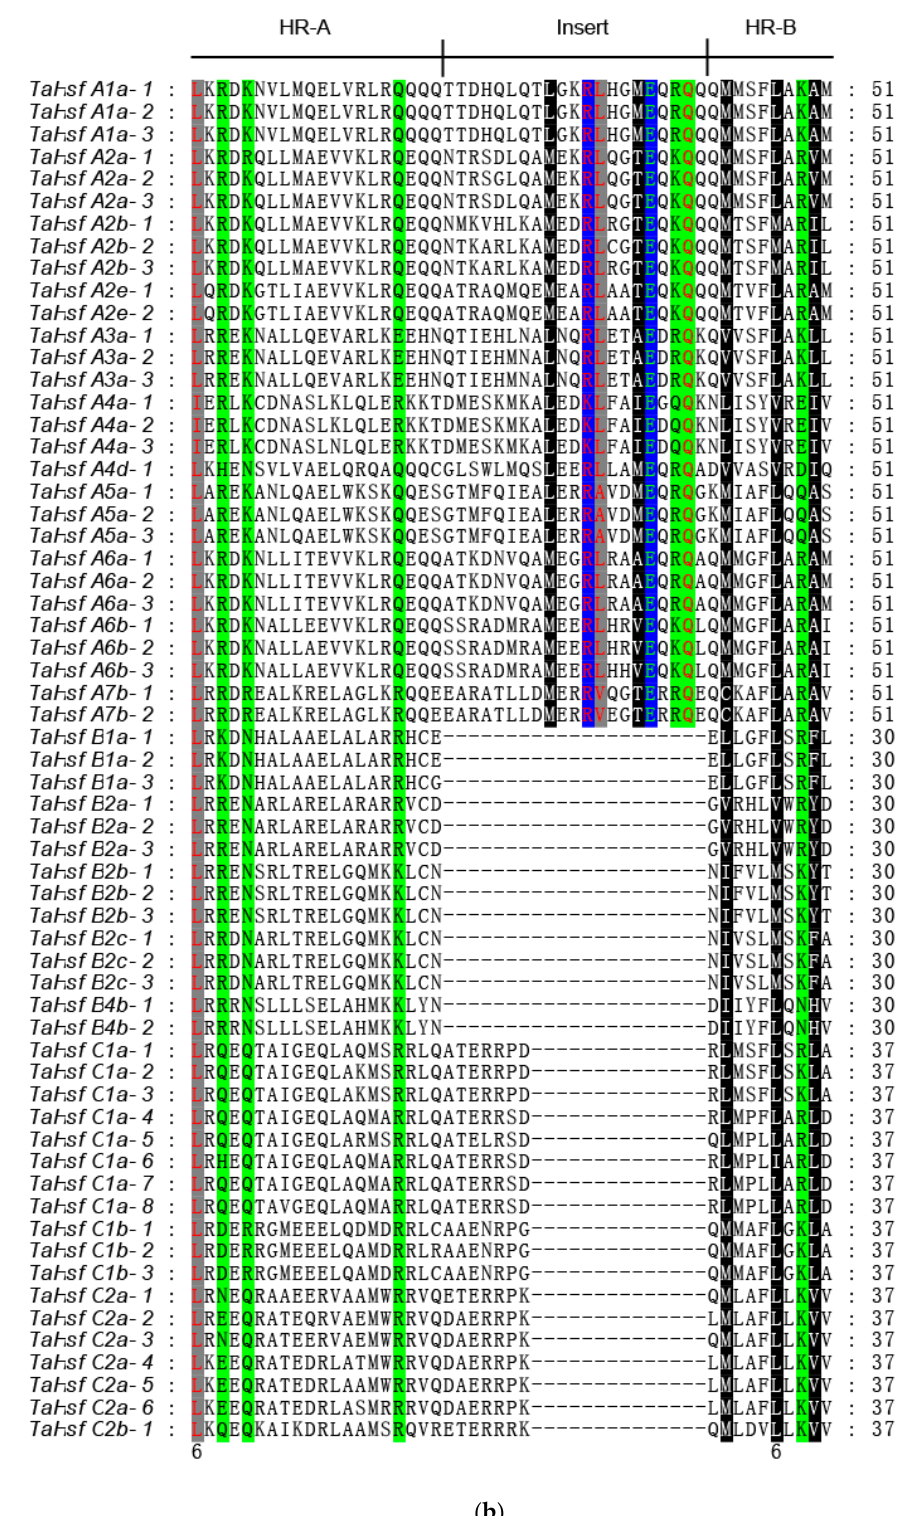
Figure 4. Analysis of the conserved DNA-binding domain (DBD) domains and oligomeric domain (OD) regions in the 61 TaHsfs . ( a ) Multiple sequence alignment of the DBD domains in 61 TaHsfs . ( b ) Multiple sequence alignment of the heptad repeat A / B (HR-A / B) regions in 61 TaHsfs . The scheme at the top shows the locations and boundaries of the HR-A core, insert, and HR-B regions within the HR-A / B regions.